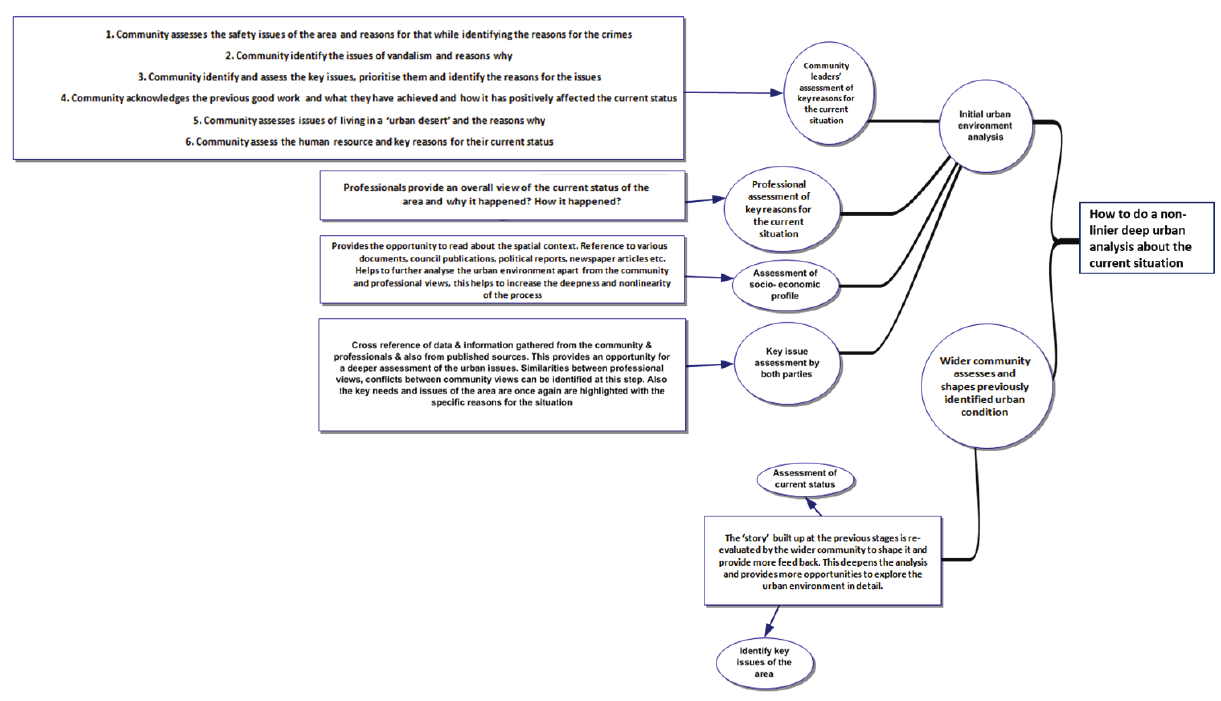
Figure 3. Ways in which to do a non-linear deep urban analysis of the current